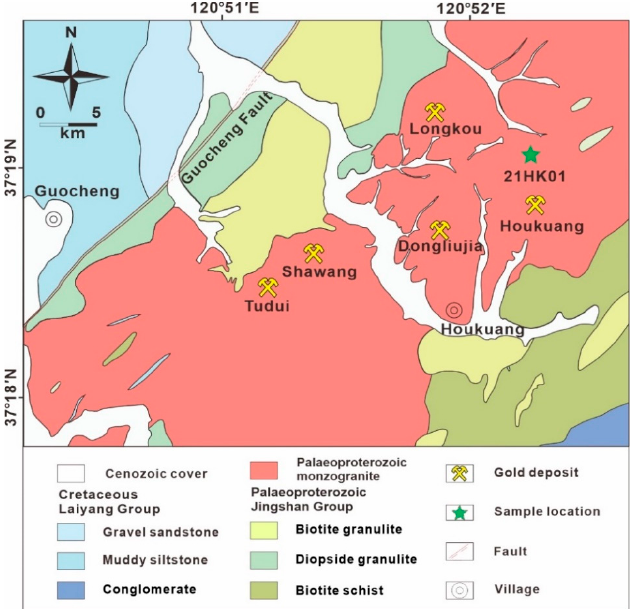
Figure 2. Geological map of the Houkuang gold deposit in the Jiaolai Basin showing the major geological units and sample locations [35] .